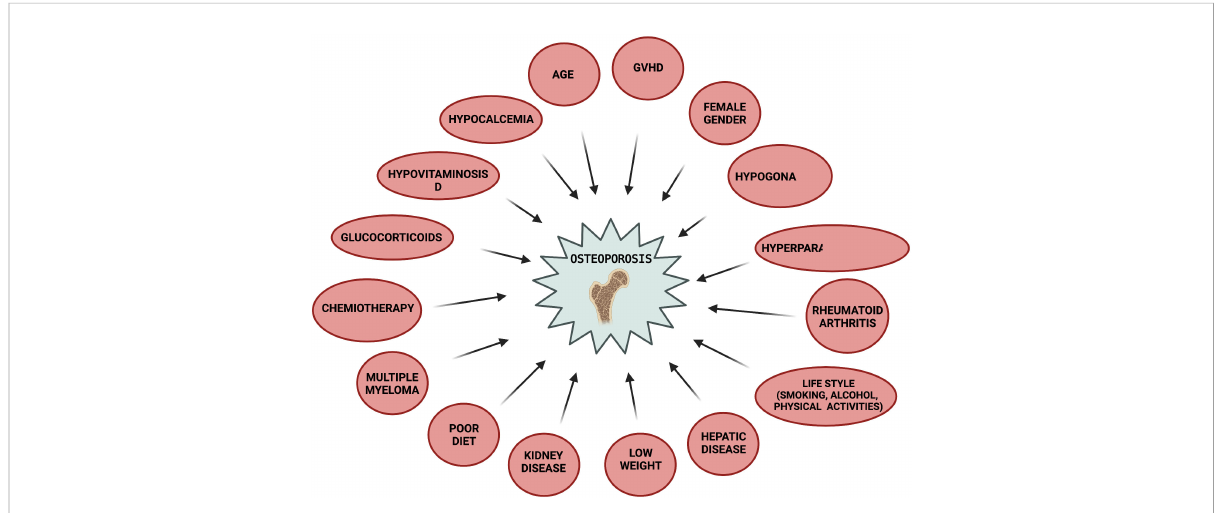
FIGURE 2 Risk factors for post-HSCT osteoporosis. Created by